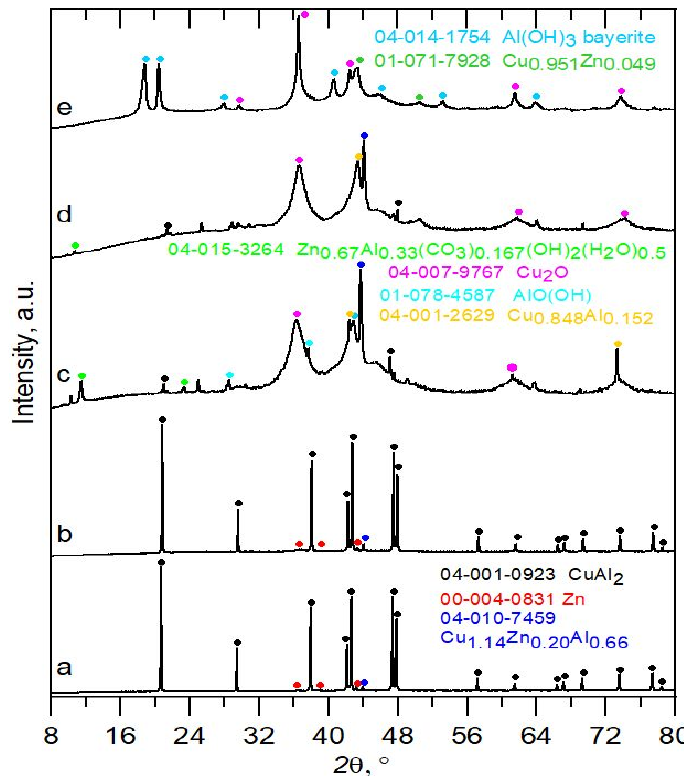
Figure 11. Powder X-ray diffraction patterns of commercial Devarda’s Al-Cu-Zn alloy ( a ), of the used Al-Cu-Zn after 25 min of action ( b ), after 40 min ( c ), after 60 min ( d ) and at the end of HDC reaction ( e ) in 1 wt.% NaOH / HCB in H 2 O:CH 3 OH = 1:1.